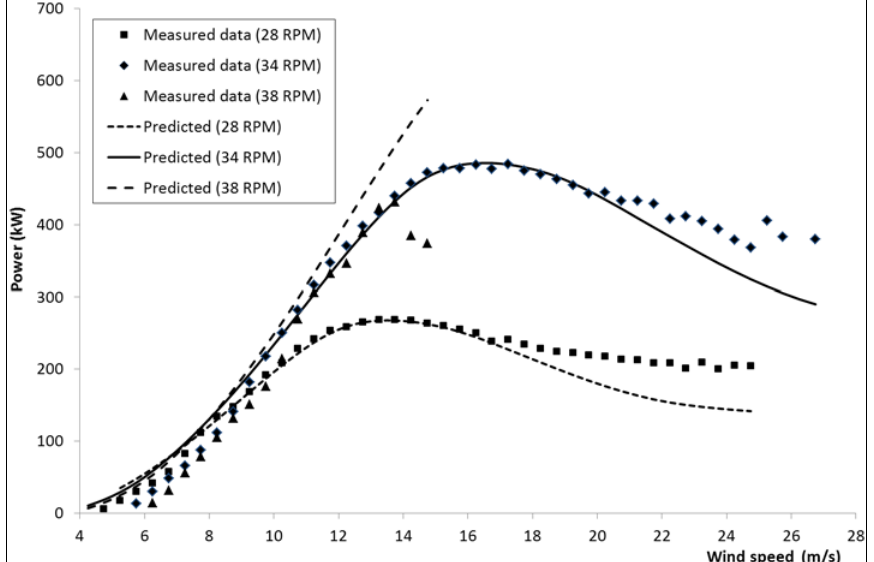
Figure 5. Sandia 34m Φ-rotor power vs. wind